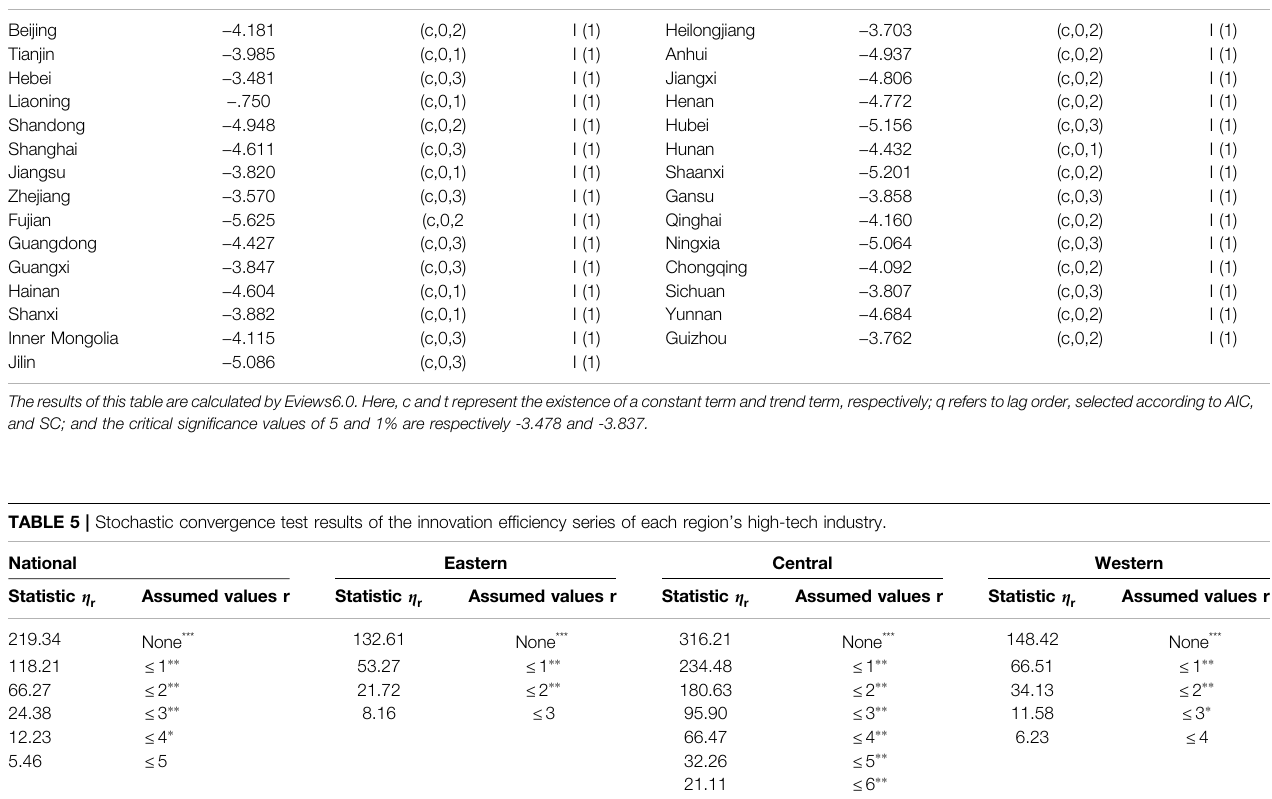
TABLE 4 | Stationary test of the innovation ef fi ciency series of the high-tech industry in China ’ s provinces. Region ADF test value of fi rst-order difference